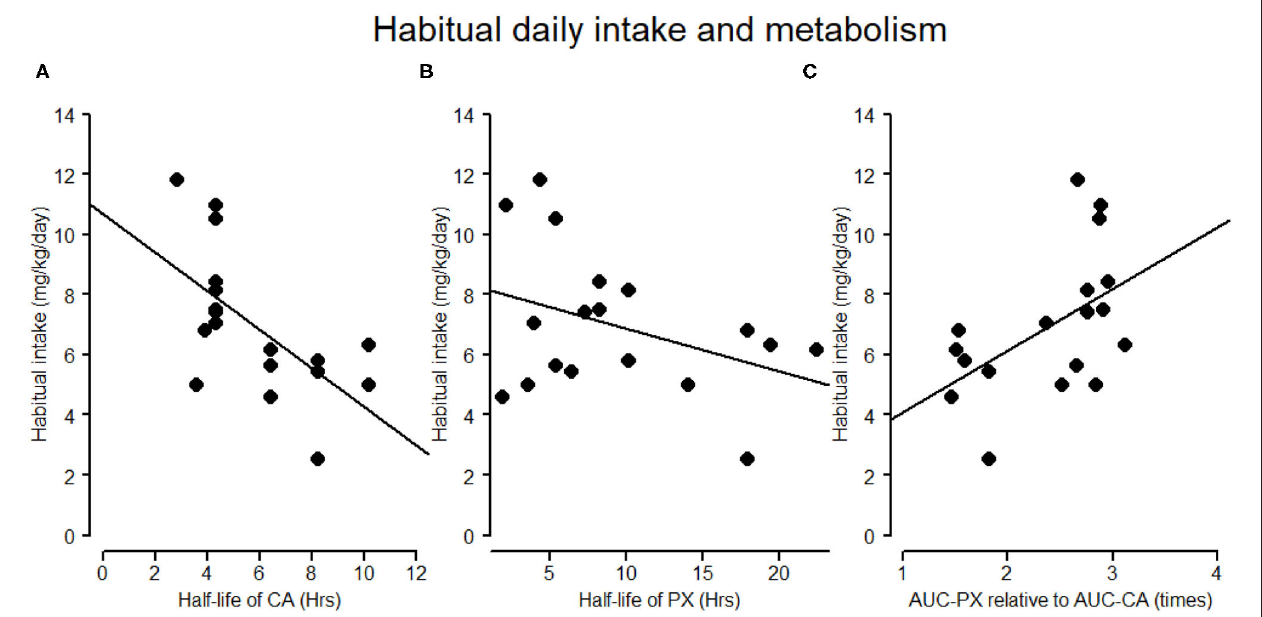
FIGURE 3 | Associations of habitual daily intake and half-lives of caffeine and paraxanthine. (A,B) The negative association between habitual self-reported caffeine intake (mg/kg/day) and the half-life of caffeine and paraxanthine in the caffeine condition, respectively. (C) The association between habitual caffeine intake (mg/kg/day) and the ratio of AUC of paraxanthine (AUC-PX) to AUC of CA (AUC-CA). In (C) a high ratio of AUC-PX to AUC-CA indicates a larger disproportional accumulation between paraxanthine and caffeine.